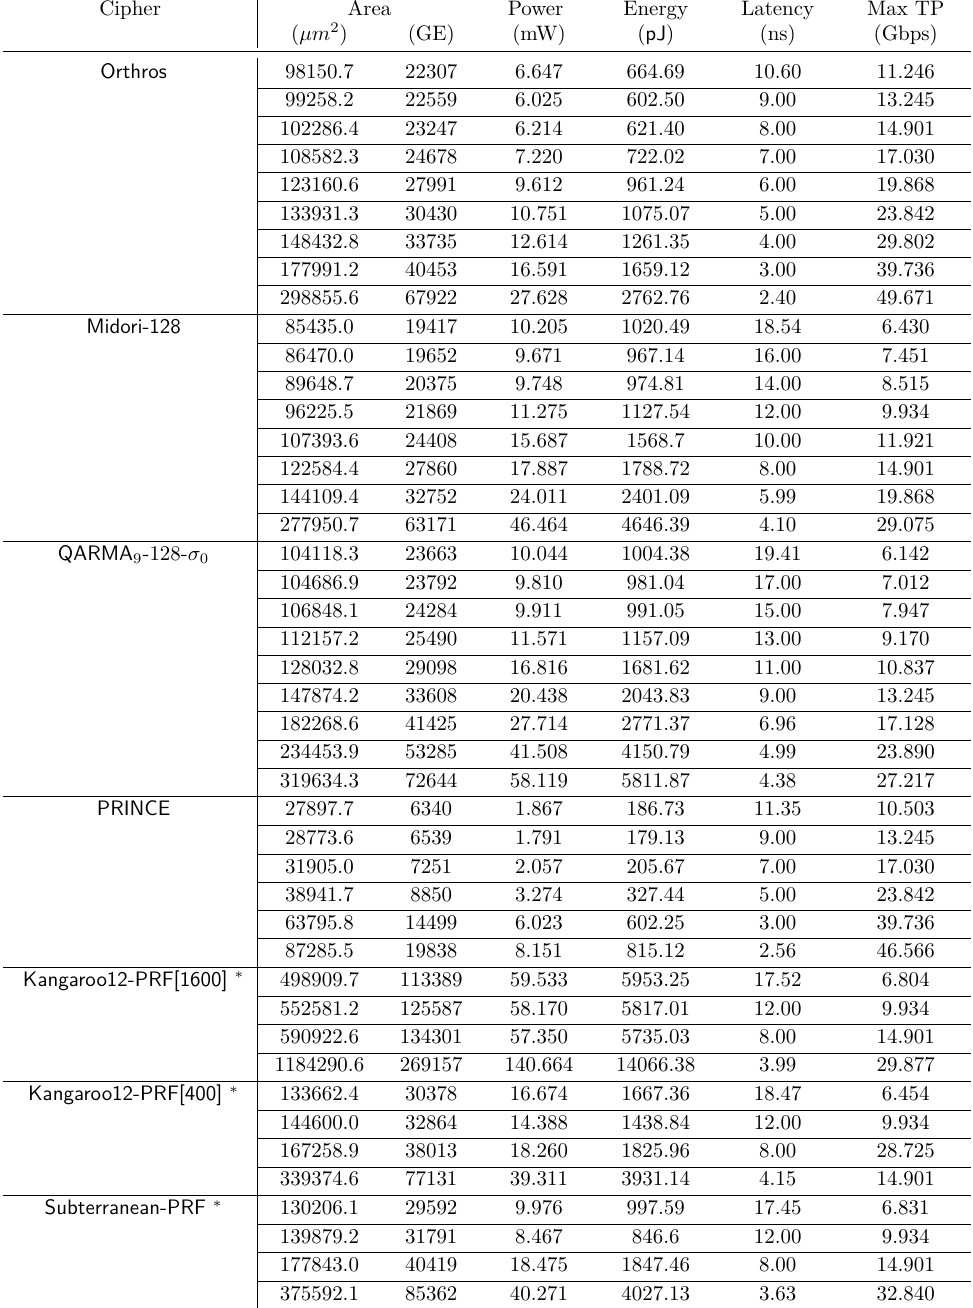
Table 9: Results for the STM 90nm library. Power measured at 10 MHz. ∗ The core implementation of the underlying permutations in these constructions were taken from [BDH +